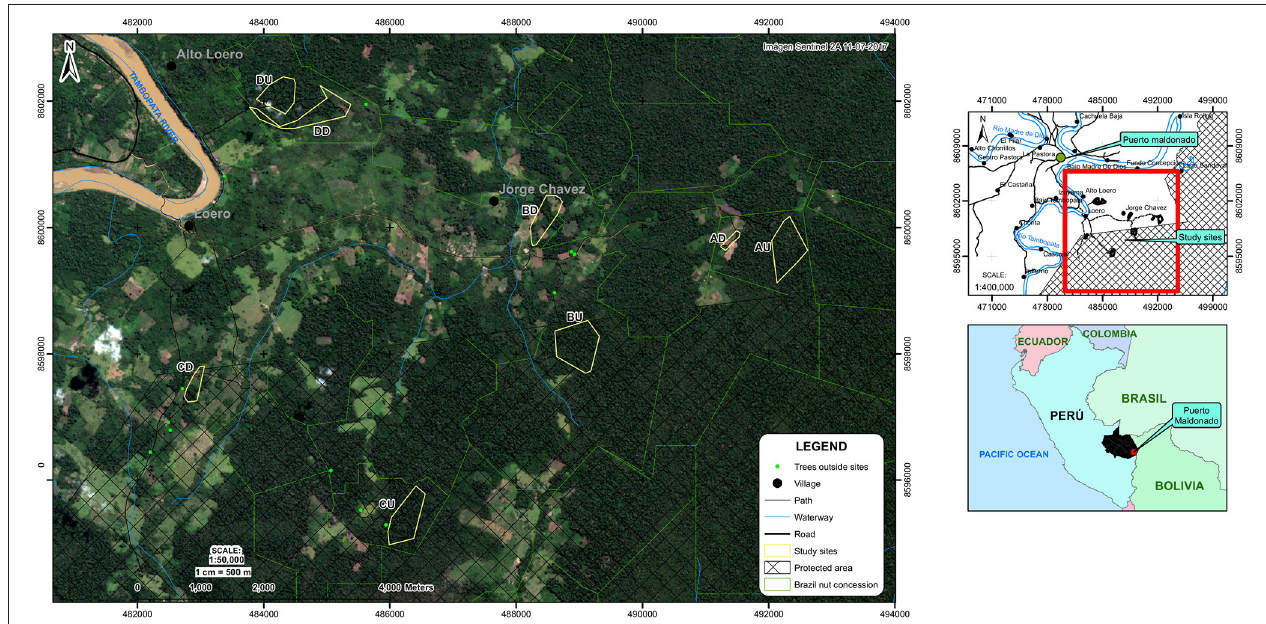
FIGURE 1 | Location research sites. The sites ending in “U” or “D” are the undegraded and degraded forest sites respectively, located in areas A–D. Sources: Esri, INEI, MTC, IGN, SERNANP, DSFLPR-MDD, GERFOR-MDD, SENTINEL 2A.